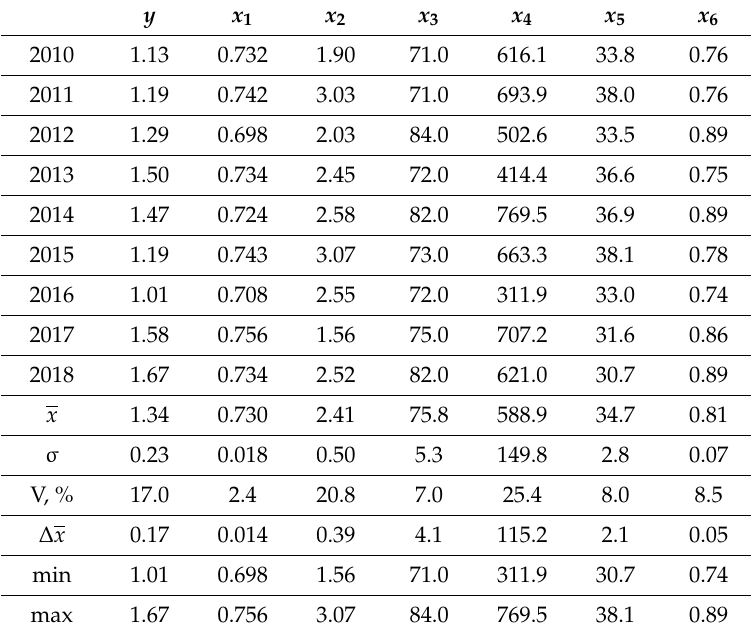
Table 5. Soybean yield ( y ), maximum NDVI ( x 1 ), and the meteorological indicators for the Khabarovsk District ( x 2 – x 6 ) in